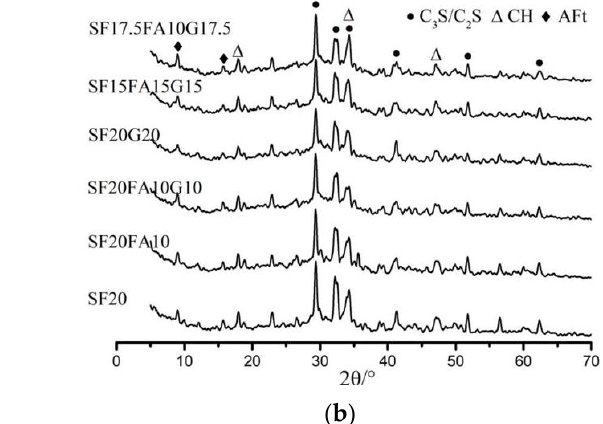
Figure 4. XRD of EUHPC at the age of 7 days and 28 days under standard curing: ( a ) XRD at the age of 7 days; ( b ) XRD at the age of 28 days.